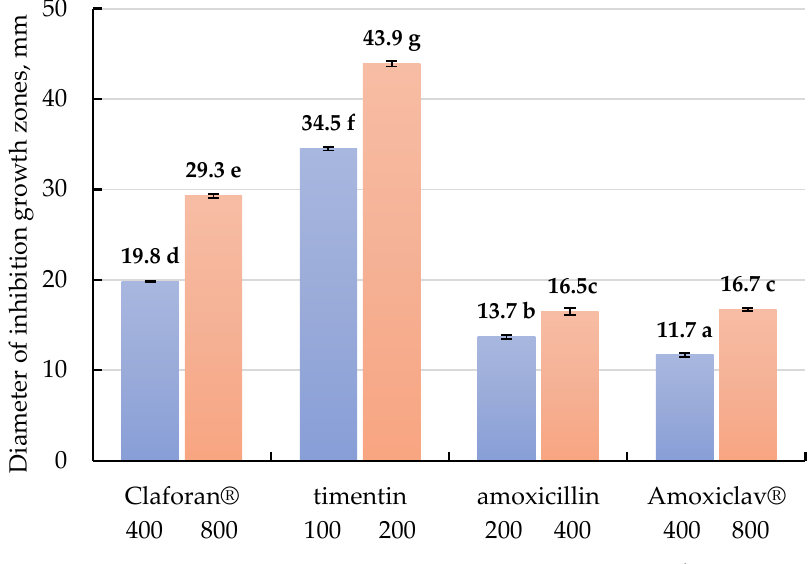
Figure 3. Influence of different β -lactam antibiotics on A. tumefaciens growth inhibition (strain AGL0) using agar disk-diffusion assay. The figure shows mean values ± standard errors. Means followed by the same letter are not significantly different at α = 0.05 according to the Duncan’s multiple range test.